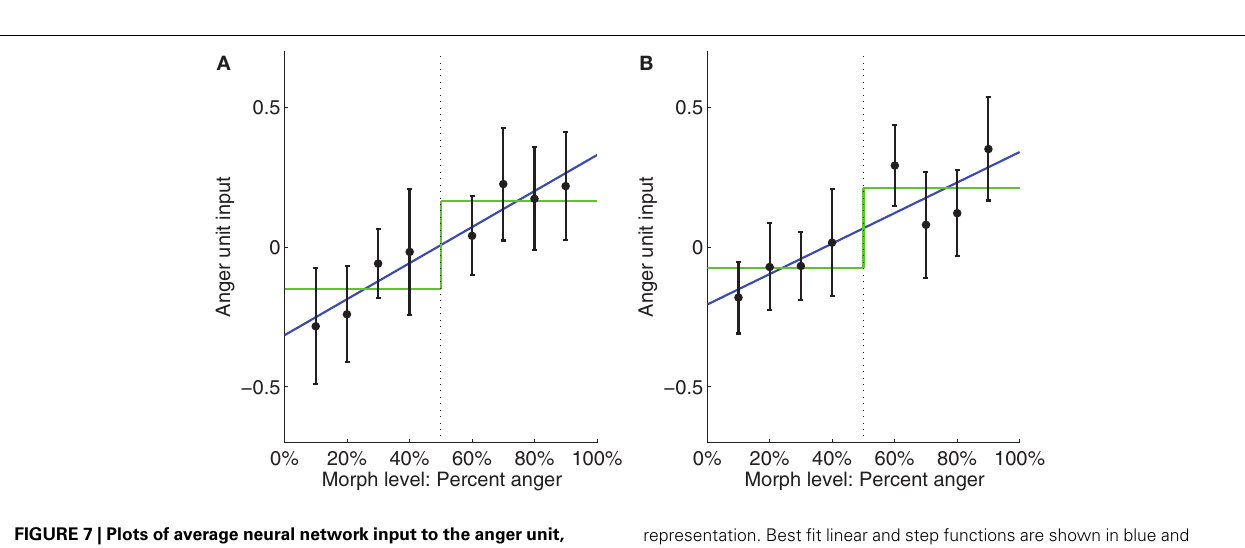
FIGURE 7 | Plots of average neural network input to the anger unit, which is used as a measure of neural representation against morph level. Low activation values indicate the brain pattern is close to the fear representation. High activation values indicate it is close to the anger